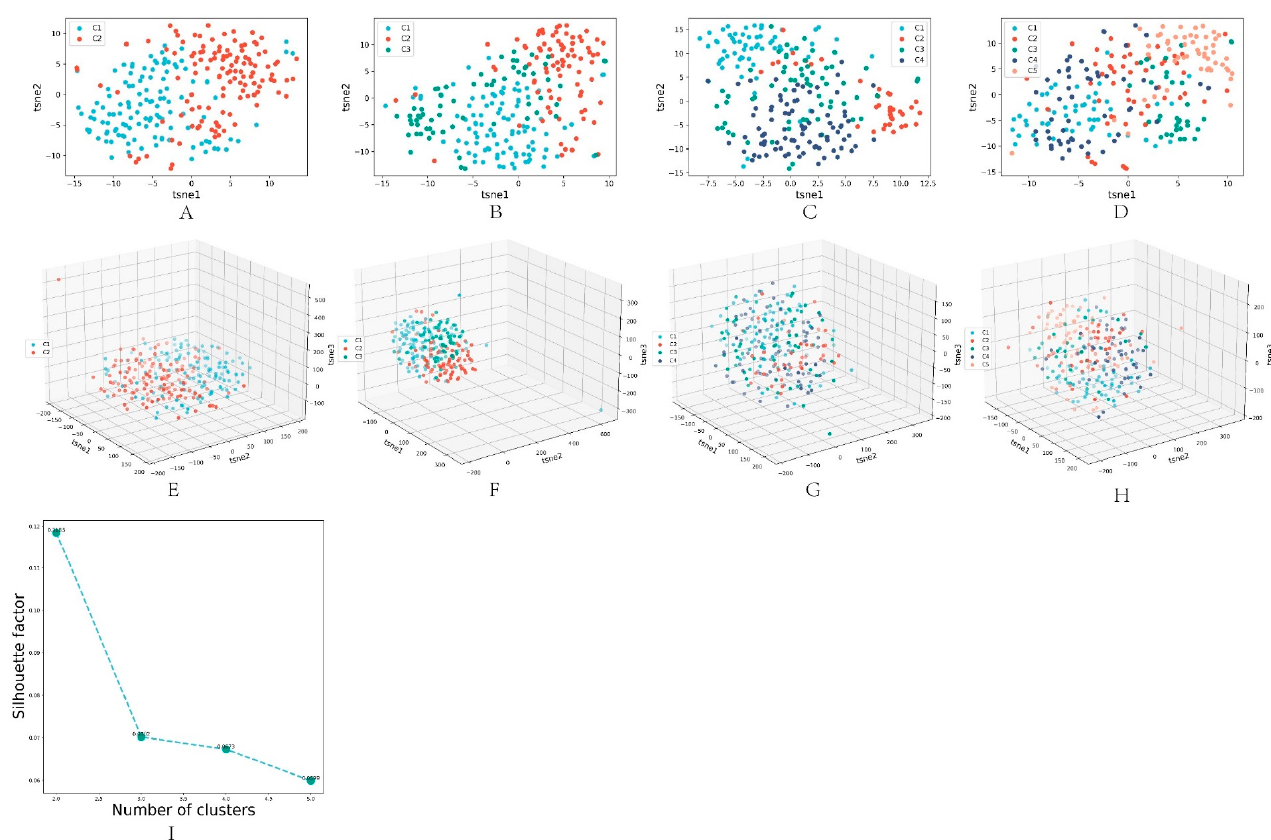
Figure 3. Results obtained under the best parameters for different cluster numbers. ( A – D ) are 2D visualized scatter plots of other cluster numbers (2 to 5) obtained using the t-sne dimensionality reduction algorithm. ( E – H ) are 3D visualization scatter plots of different cluster numbers (2 to 5) obtained using the t-sne dimensionality reduction algorithm. ( I ) is the line plot of the contour coefficient change as the number of clusters increases.